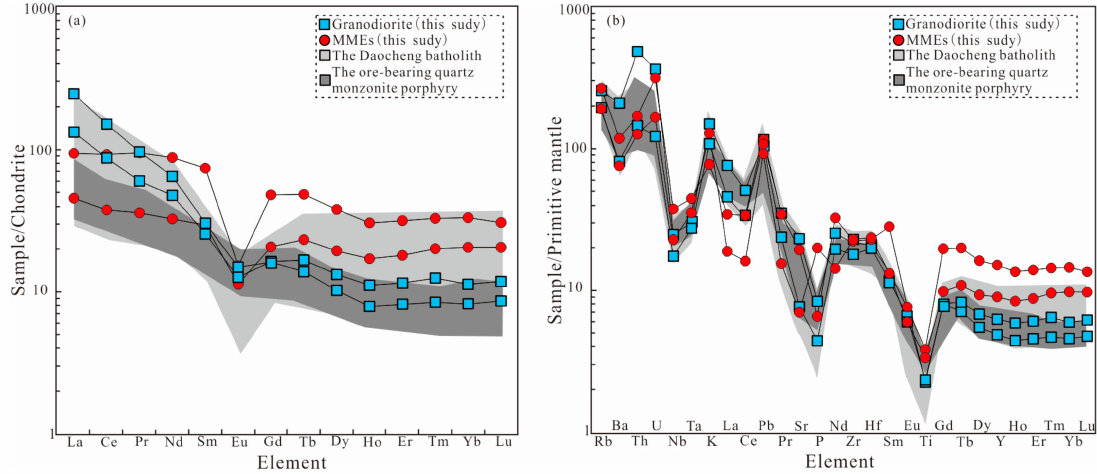
Figure 5. Chondrite-normalized rare-earth elements (REE) patterns and primary mantle-normalized trace element spidergrams for granodiorite and MMEs. ( a ) chondrite-normalized REE and ( b ) primary mantle-normalized trace